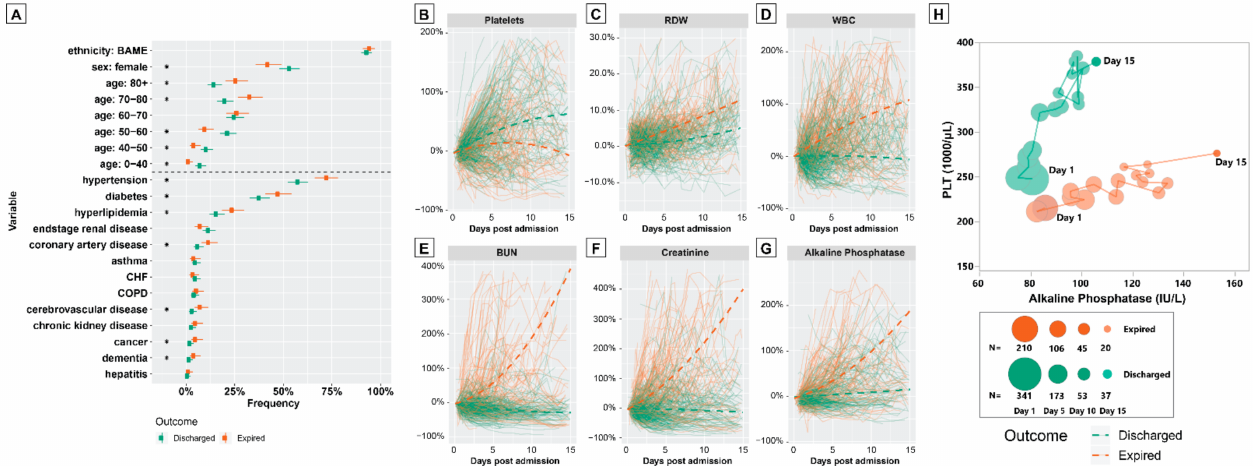
Figure 2. ( A ) Characteristics of patients according to outcome: the points indicate posterior median frequencies and the upper and lower whiskers indicate 2.5% and 97.5% posterior quantiles, calculated assuming a uniform prior and binomial likelihood. Asterisks indicate that the overlap in posteriors for each outcome was less than 0.05 for a given variable. (BAME refers to patients of non-Caucasian ethnicity.) ( B – H ) Time-series graphs of select laboratory values in hospitalized COVID-19 patients: Panels ( B – G ) show individual patient trajectories (solid lines) colored according to outcome for a selection of tests; dashed lines show fitted regression lines (see supplementary materials) for patients grouped by outcome). Panel ( H ) shows daily averages of platelets count (vertical axis) versus alkaline phosphatase levels (horizontal axis) for all patients remaining in hospital during the first 15 days of hospitalization. Each point indicates the paired mean of both tests for one of the two patient groups. (CHF: congestive heart failure, COPD: chronic obstructive pulmonary disease, N: